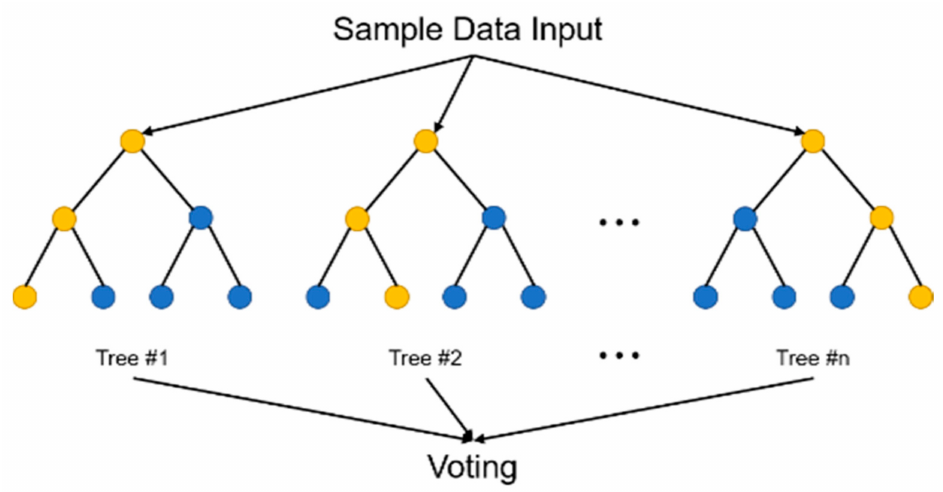
Figure 3. Schematic of the random forest